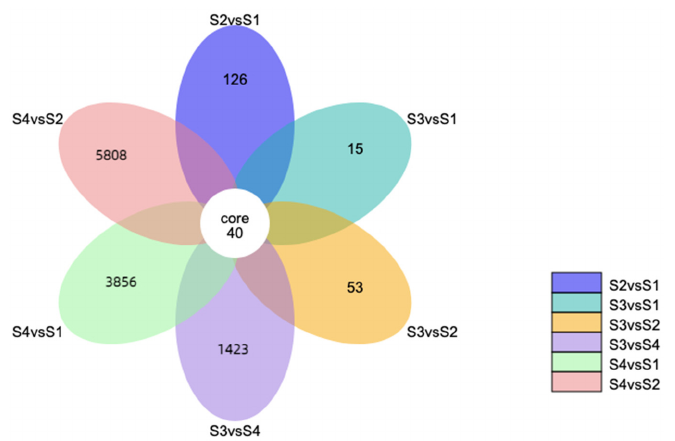
Figure 1. Venn diagram of 6 comparison groups in four periods S1–S4. Different colors represent different expressed genes in different comparison groups, and overlapping positions represent common different expressed genes in different comparison groups.